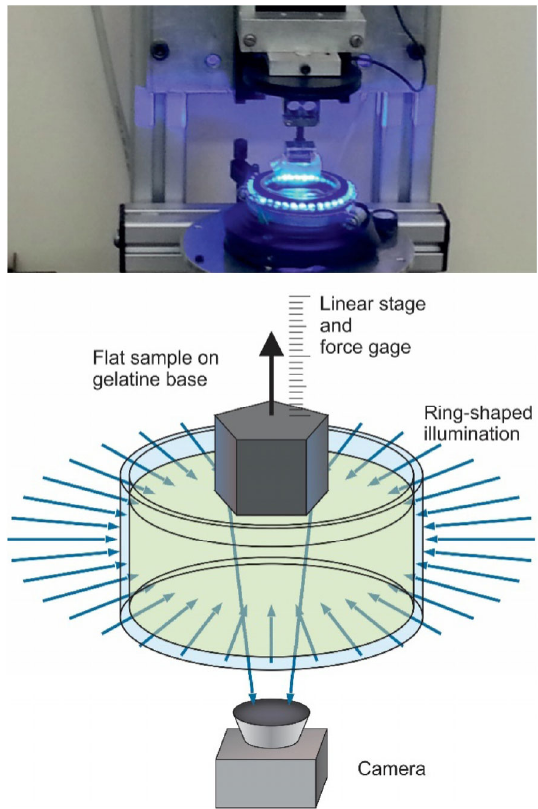
Fig. 12 Schematic display of the experimental setup. A flat but oddly shaped sample of acrylic glass is placed on a gelatin base and slowly pulled off. The contact between both can be observed by a camera through the gelatin. For increased visibility of the edges, the contact zone is illuminated in a circular fashion.